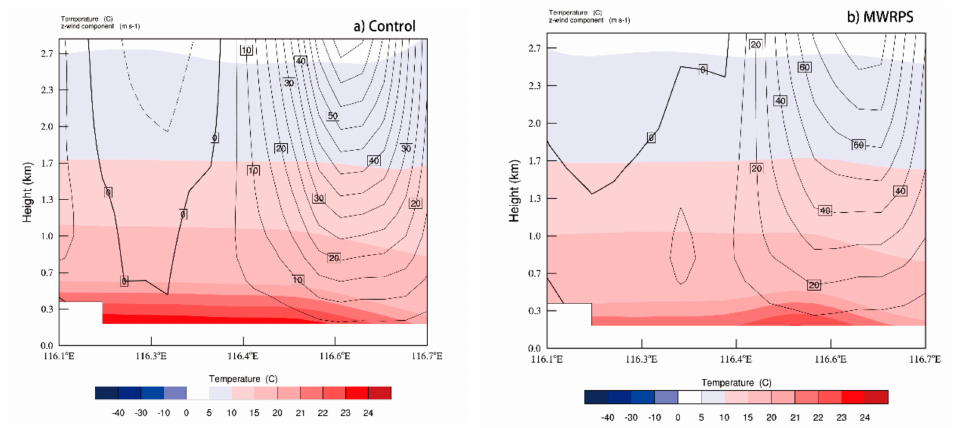
Figure 10. The cross sections of the vertical profiles along 40 ◦ N from control ( a ) and MWRPS ( b ) forecast field at 0800 UTC on 21 May 2020, in which the vertical velocity (unit: 10 − 1 m/s) is represented as the contour, and the temperature (unit: ◦ C) is represented as